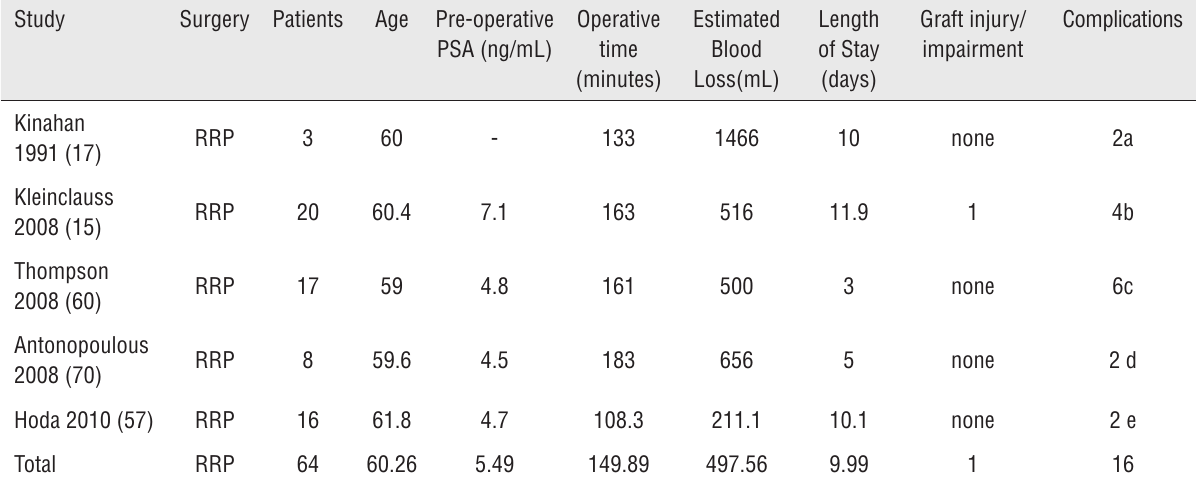
Table 3 - Radical prostatectomy in the Renal Transplant Recipient population (15, 17, 60-71). Radical Retropubic prostatectomy (RRp)